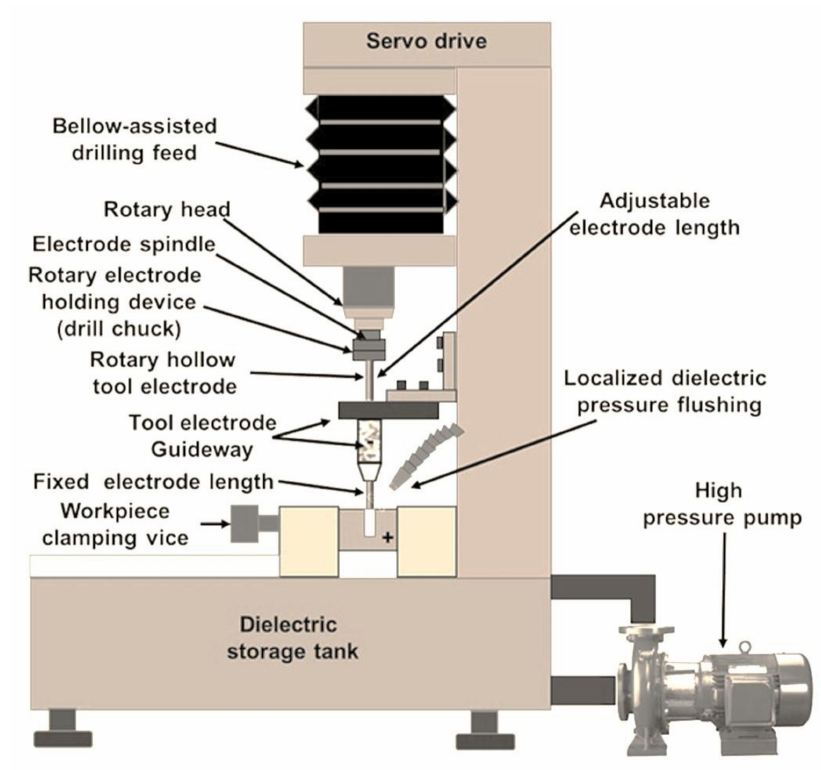
Figure 3. Schematic representation of micro-spark-erosion drilling ( µ -SED)